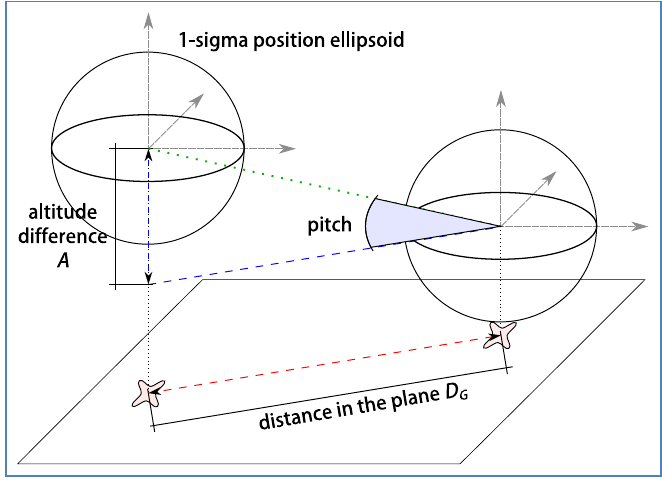
Figure 12. Calculation of elevation angle from two GPS